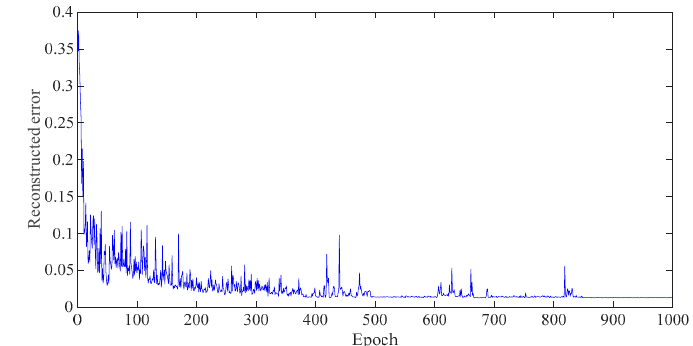
Figure 10. Global training error of the DBN in fine-tuning. Table 3. Recognition results of the DBN model.